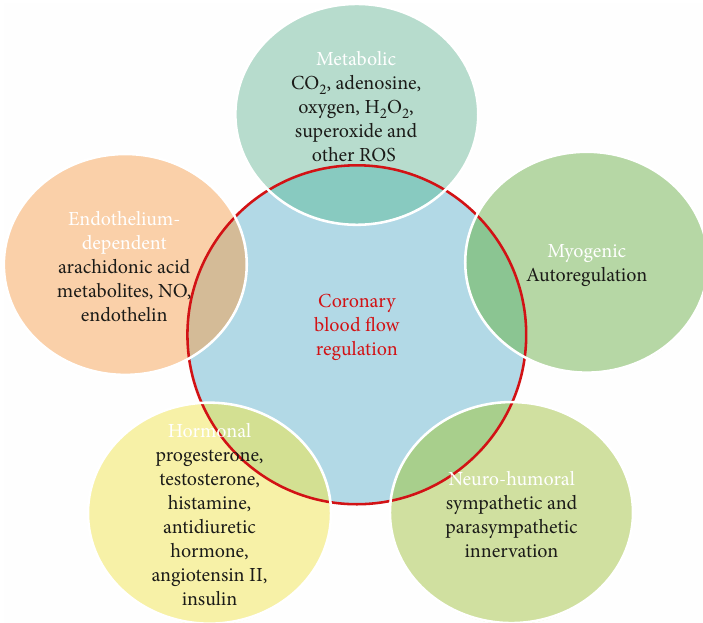
Figure 4: Di ff erent mechanisms involved in coronary blood fl ow